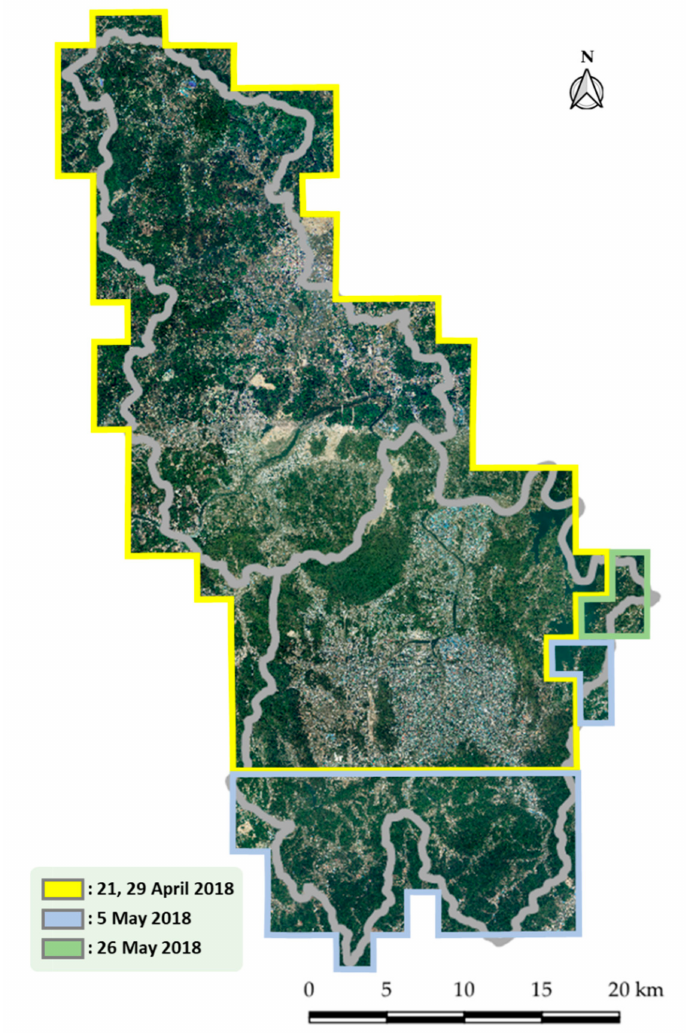
Figure 2. Aerial orthoimages over the study area with the acquisition